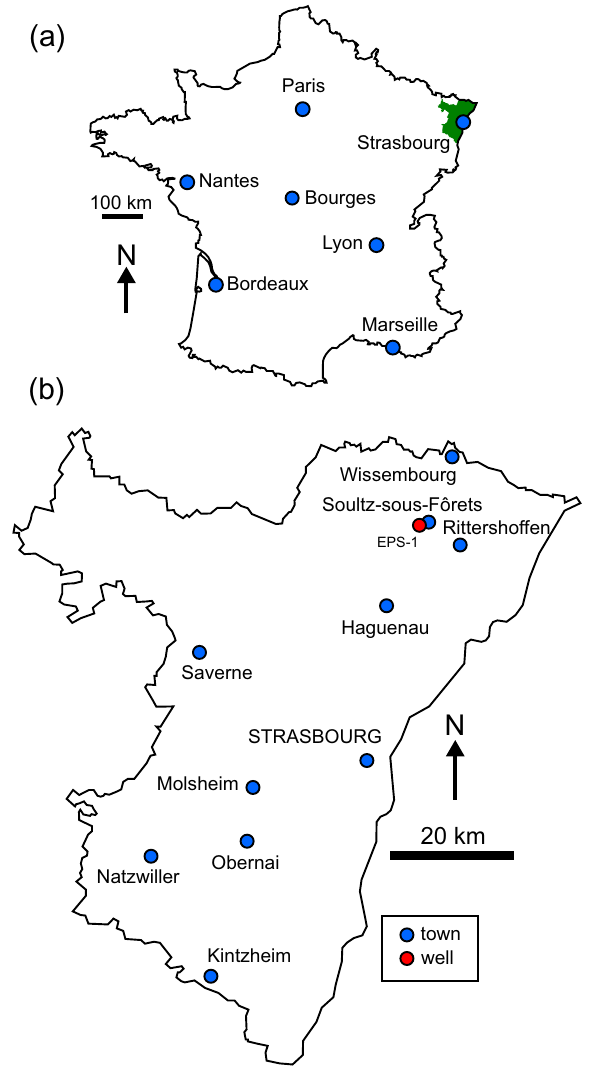
Fig. 1 a Map of France showing location of Alsace (in green). b Map of Alsace showing the location of Soultz-sous-Forêts and exploration borehole EPS-1. Modified from Heap et al.